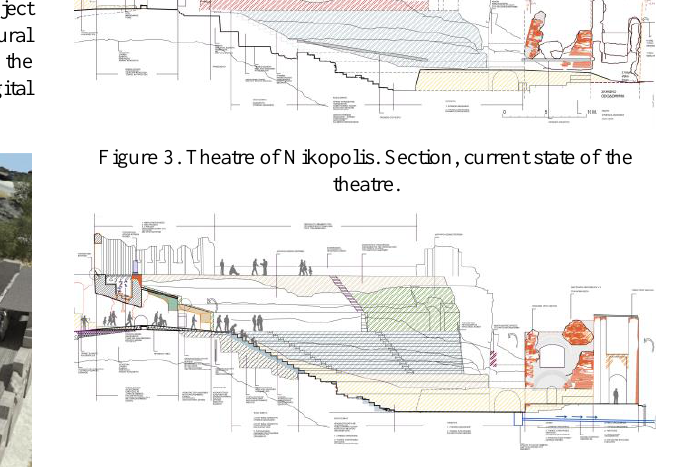
Figure 4. Theatre of Nikopolis. Section, restoration proposal. Figure 2. 3D virtual representation of the restoration proposal: General view.